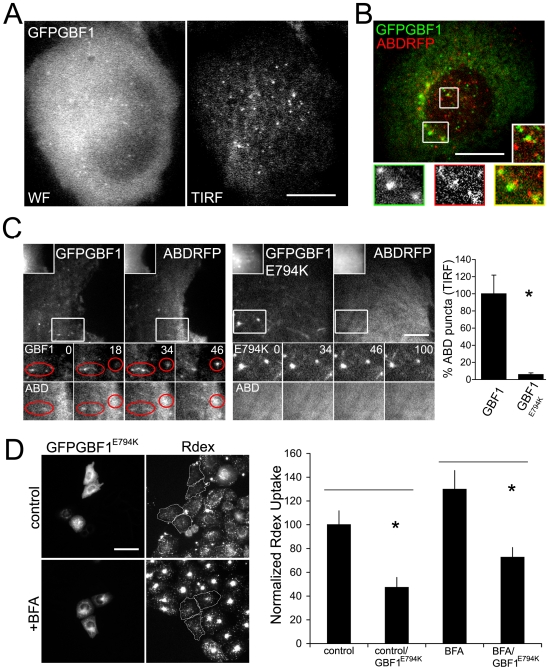
Functional significance of GBF1 dynamics in the vicinity of the plasma membrane.(A) A CHO cell expressing low levels of GFPGBF1 imaged with widefield fluorescence microscopy (WF; left panel) or with TIRF microscopy (right panel) to reveal puncta close to the plasma membrane. (B) Fast sequential two-colour confocal imaging of a live CHO cell expressing GFPGBF1 and ABDRFP (activated Arf sensor; Kumari and Mayor, 2008). The colour merged image is a composite of the most peripheral plane of the cell in each channel (encompassing ∼200 nm in the z-axis, 30 msec between each plane). Two boxed regions in the cell are magnified, the smaller as the merge inset, and the individual channels from the larger region are shown below. (C) Time lapse, sequential TIRF imaging of a CHO cell co-expressing GFPGBF1 and ABDRFP (left panels) or co-expressing GFPGBF1E794K and ABDRFP (right panels). The main reference images in each panel show dual-channel sets of TIRF images for a single time point, with a ∼1 sec gap between channel acquisition. The insets in the reference images show the same plane imaged with widefield microscopy. The boxed regions are magnified and shown as a time series for each channel, with the time elapsed since the first reference frame displayed in seconds. Transient punctate or elongated structures that traverse the evanescent field and acquire both GFPGBF and ABDRFP over the time-lapse are circled in red. In the cell expressing GFPGBF1E794K, these structures persist for longer times in the evanescent field (magnified time series; right panel), but do not acquire ABDRFP. Quantitatively, cells expressing GFPGBF1E794K show significantly lower numbers of ABDRFP puncta in the evanescent plane (bar graph in right panel shows mean±s.e.m. values from 20 random planes from movies of 5 cells in each case, expressed as percentage of control).(D) CHO cells transfected with GFPGBF1E794K were treated with Brefeldin A (BFA) or carrier DMSO (control) and assayed for fluid phase (Rdex) uptake. Representative fields with GBF1E794K transfected (outlined in white) and untransfected cells, with or without BFA are shown in the left panel. The bar graph in the right panel shows the corresponding quantitation of fluid phase uptake as normalized to control, untransfected cells (mean±s.e.m.; n = 63,68,60,59; asterix denote P<0.05 by Student's t-test). Bar in A,B = 10 µm, C = 2.5 µm, D = 20 µm. Insets in C are 0.25x, boxed regions are magnified 2x.